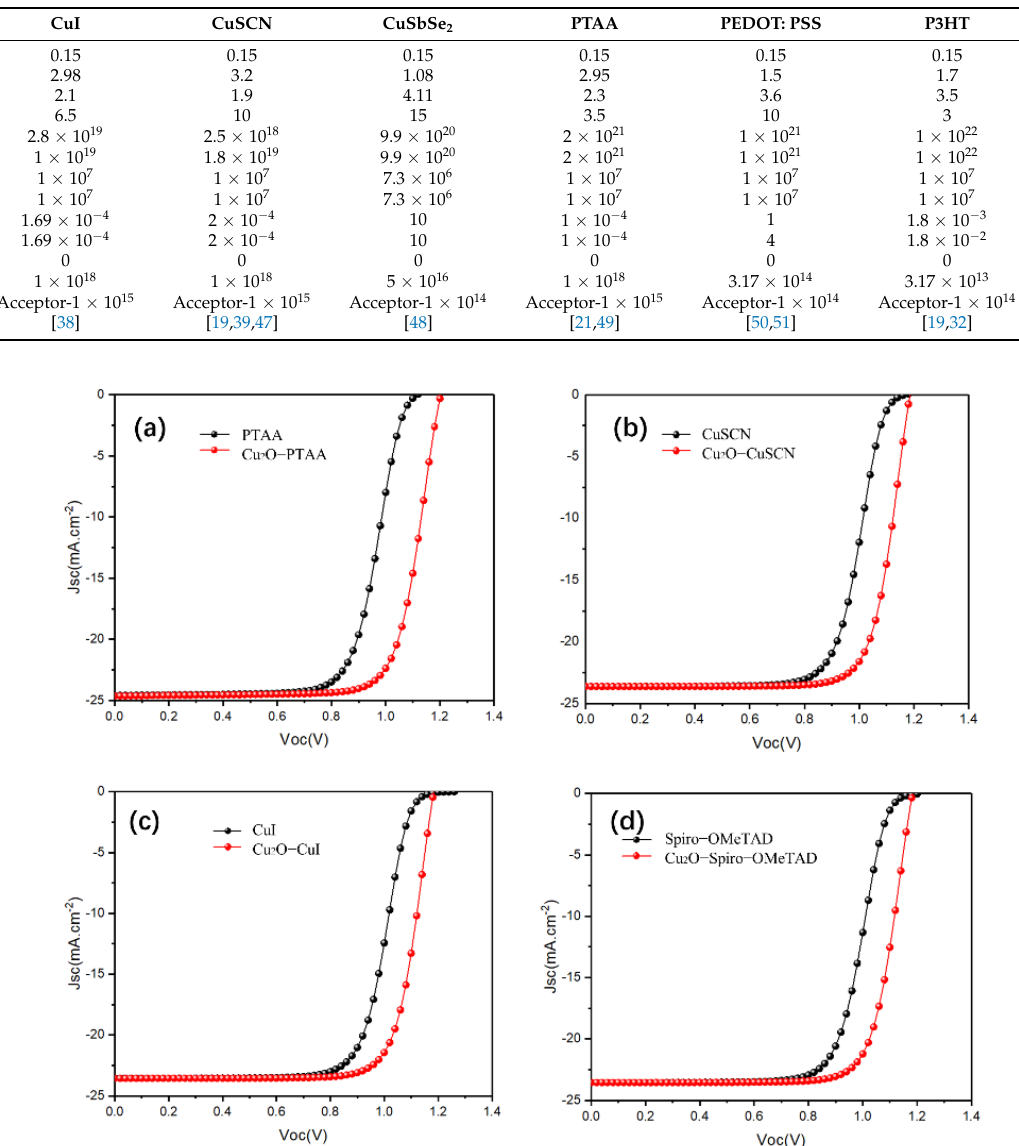
Table 3. Input parameters for the several different HTMs.